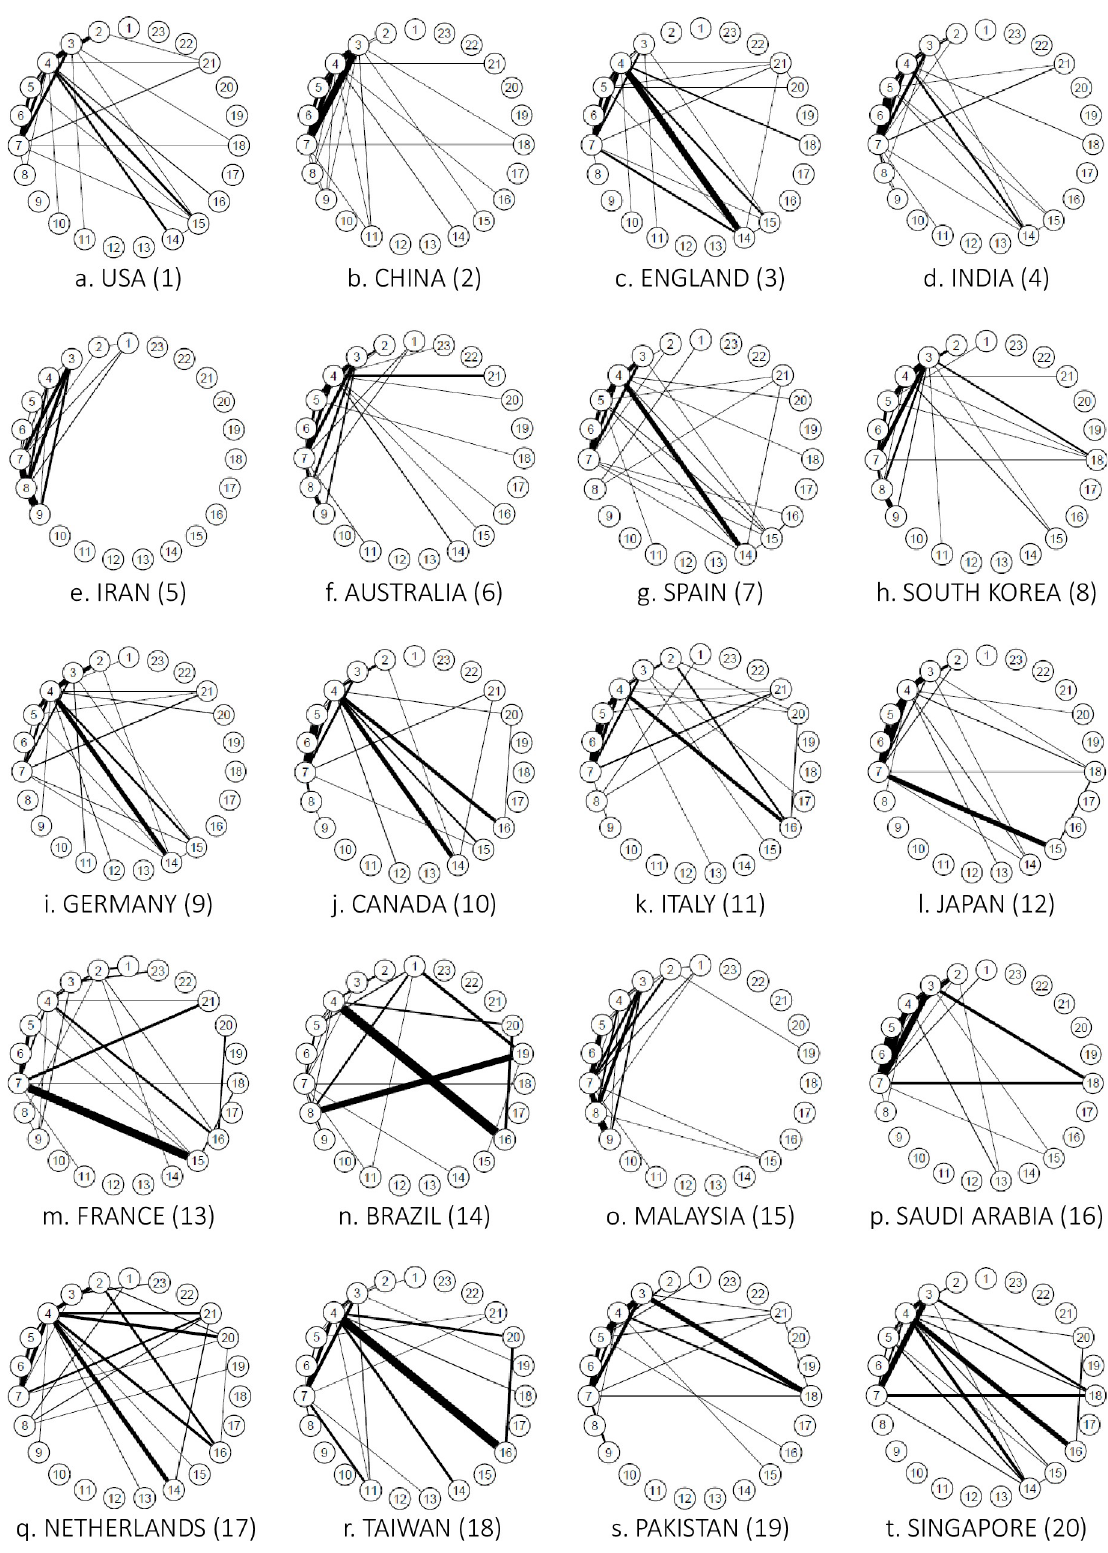
Fig 7. Connections between author research fields in the Top 20 countries for artificial intelligence (2018). Note : This indicates connections with a strength of 1.0% or more.